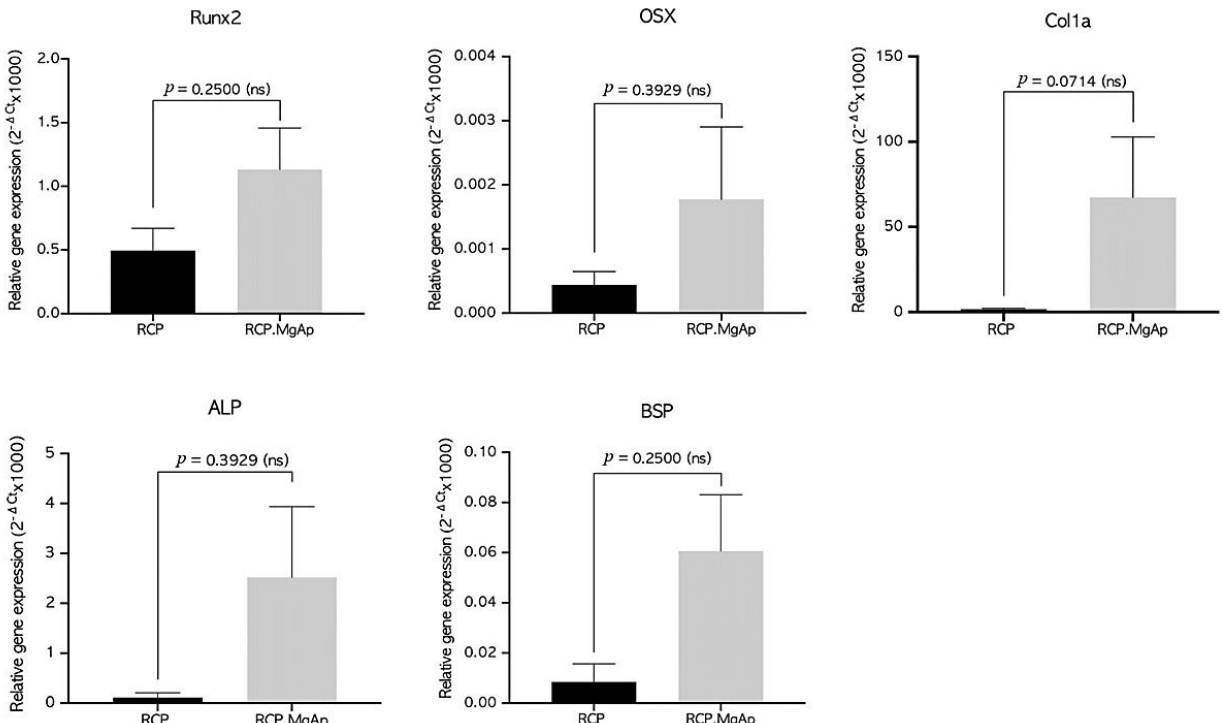
Figure 6. Relative gene expression (2 −ΔCt ) after 15 days. GAPDH housekeeping gene was used to normalize data. RUNX2 = runt-related transcription factor 2, ALP = alkaline phosphatase, Col1a = collagen type I alpha 1, OSX = osterix, BSP = bone sialoprotein. Statistical analysis using student t -test, n (RCP) = 3, n (RCP.MgAp) = 5.